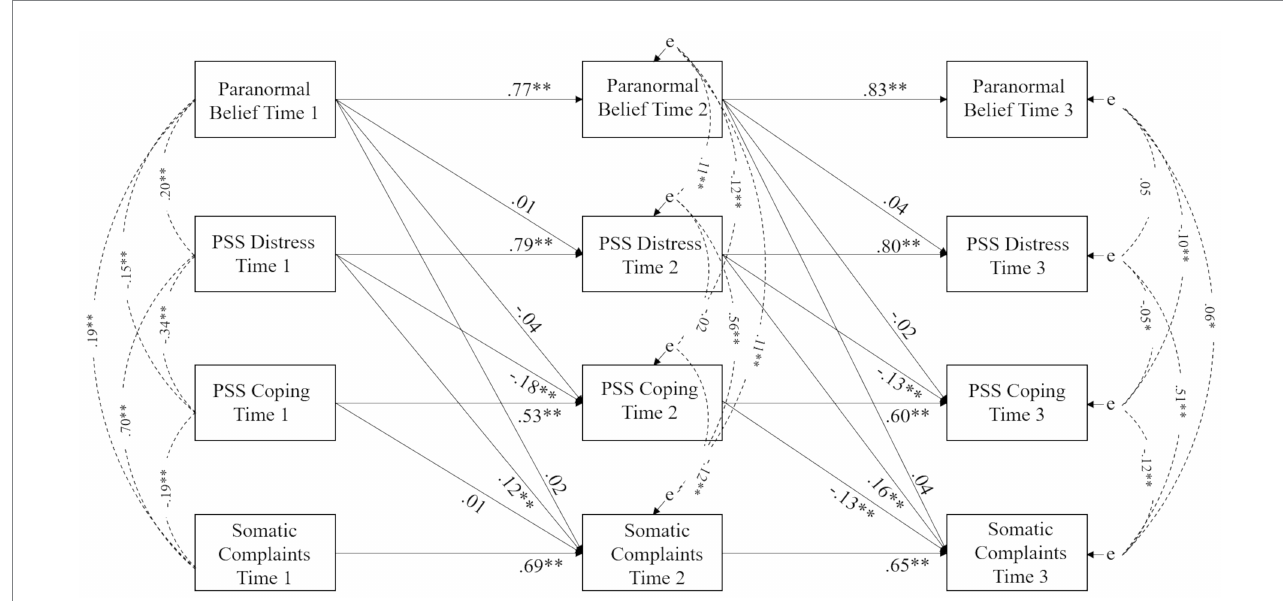
FIGURE 1 Predictive model of paranormal belief over time in relation to well-being (perceived stress and somatic complaints) using latent construct scores. Note. Standardised regression weights between variables are shown. Error is indicated by ‘e’. * p < 0.05, ** p < 0.001 using Bootstrapping significance estimates (1,000